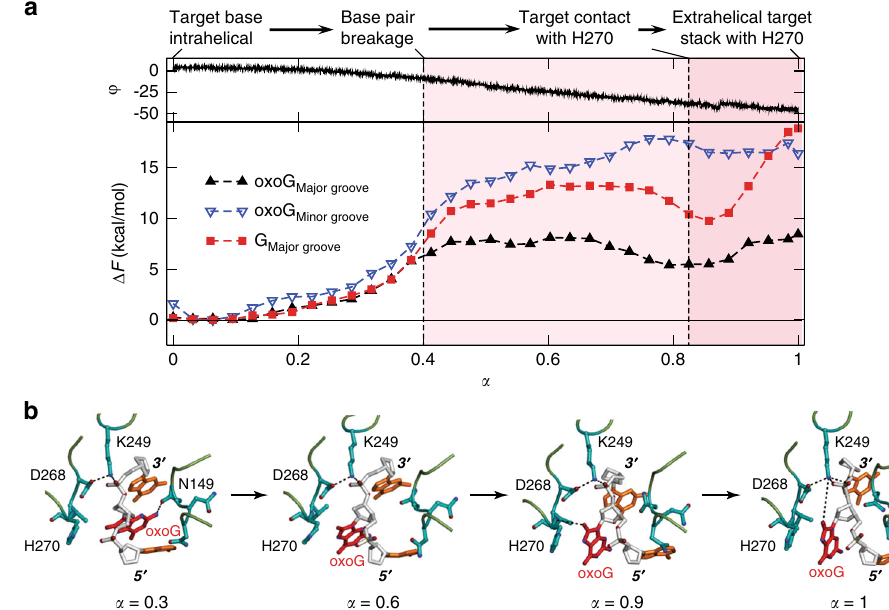
Fig. 5 Free energy pro fi les determined for the oxoG and G extrusions. a Free energy pro fi les of base extrusion by hOGG1 described by a progress variable α (see Supplementary Fig. 9 for details) between the intrahelical IC (for G) or EC (for oxoG) state ( α = 0) and the fully extrahelical state ( α = 1). Important events along the major groove base extrusion path for oxoG are indicated together with the pseudo-rotation angle φ (Supplementary Fig. 10b) describing the target base extrusion. b Snapshots from the string method in collective variables (SMCV) simulations 36 , showing the interaction of oxoG with N149, K249, and H270. Key protein sidechains are shown in cyan, DNA phosphate and sugar backbones in gray, and DNA bases in orange,